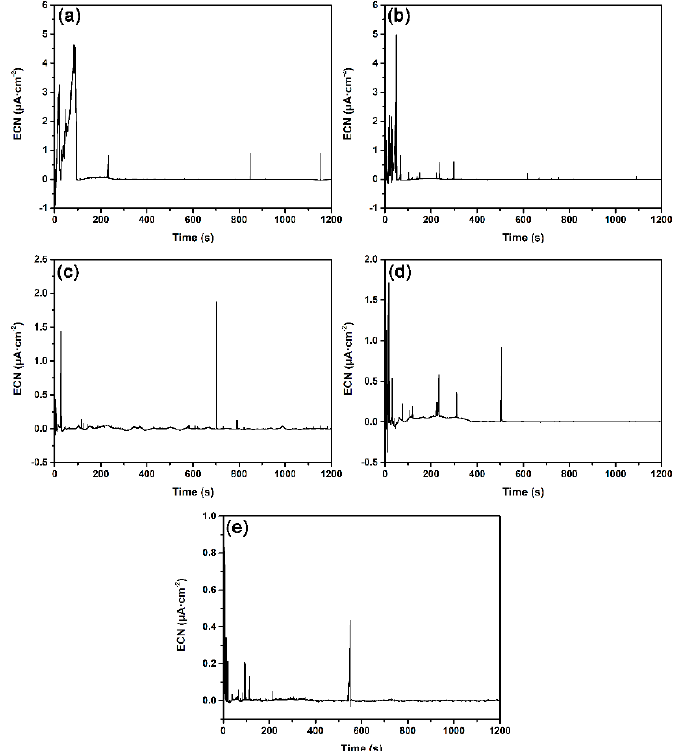
Figure 10. Typical EN time records of different surface roughness specimens of DSS 2205 at 200 mV (SCE) in NaCl solution at 55 °C: ( a ) 180#; ( b ) 600#; ( c ) 1000#; ( d ) 2000#; ( e ) polished.